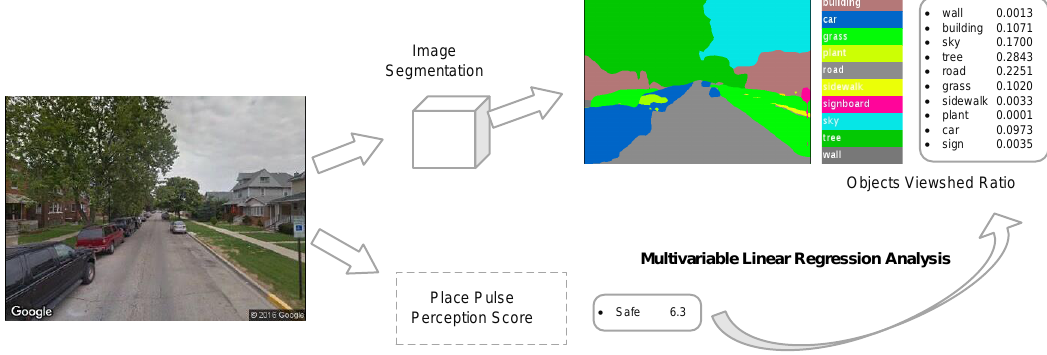
Figure 7. Overview of multivariable linear regression analysis between perceptual scores and object FOV ratio. The image samples were selected from the Place Pulse dataset with the perceptual scores. The object FOV ratio was calculated from the image using the image semantic segmentation model.